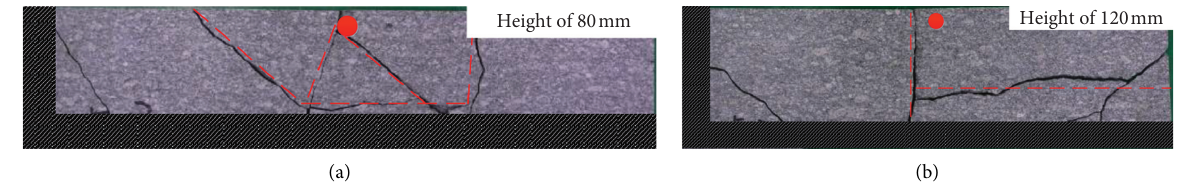
Figure 20: The cutting results with different height. (a) 80mm and (b) 120mm.